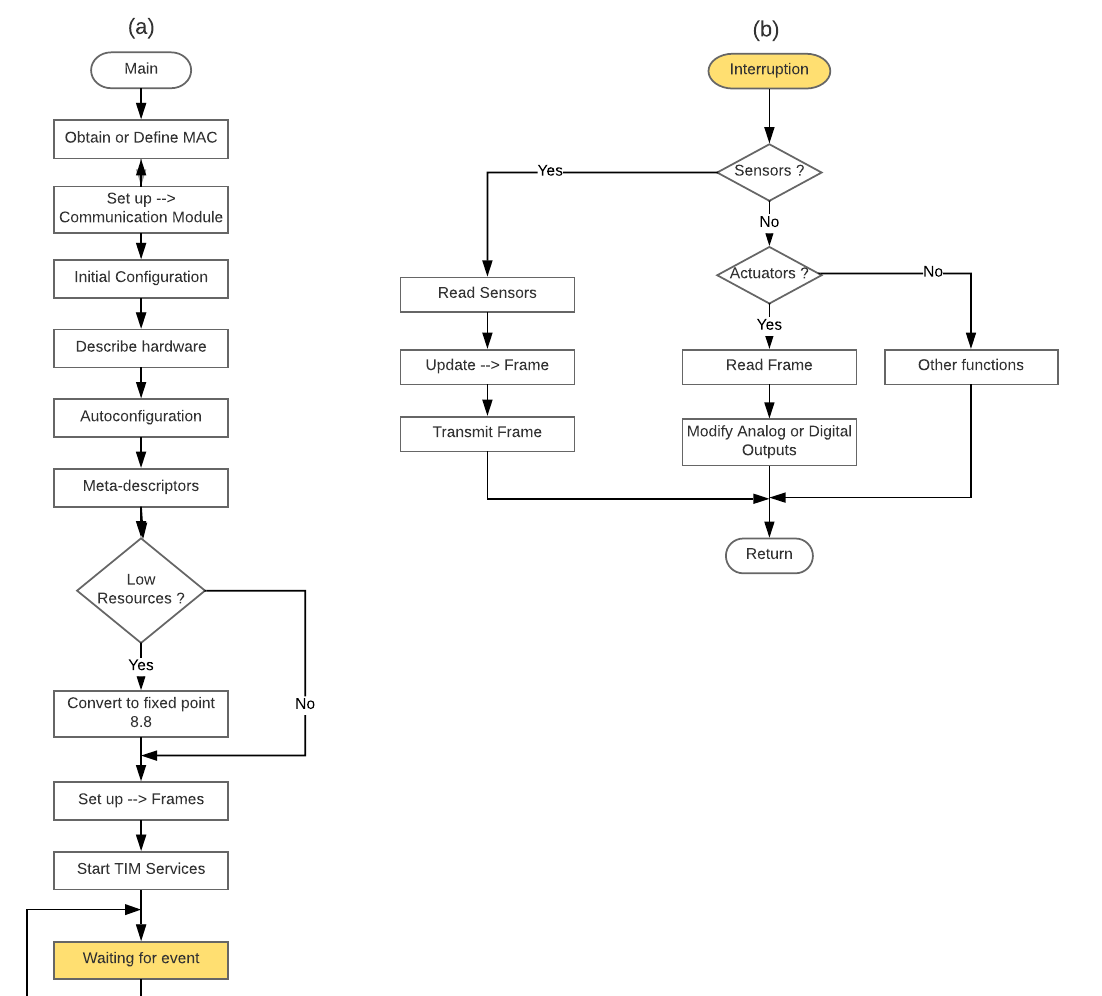
Figure 12. TIM flow diagrams: ( a ) Main program and ( b ) Interrupt Service Routine